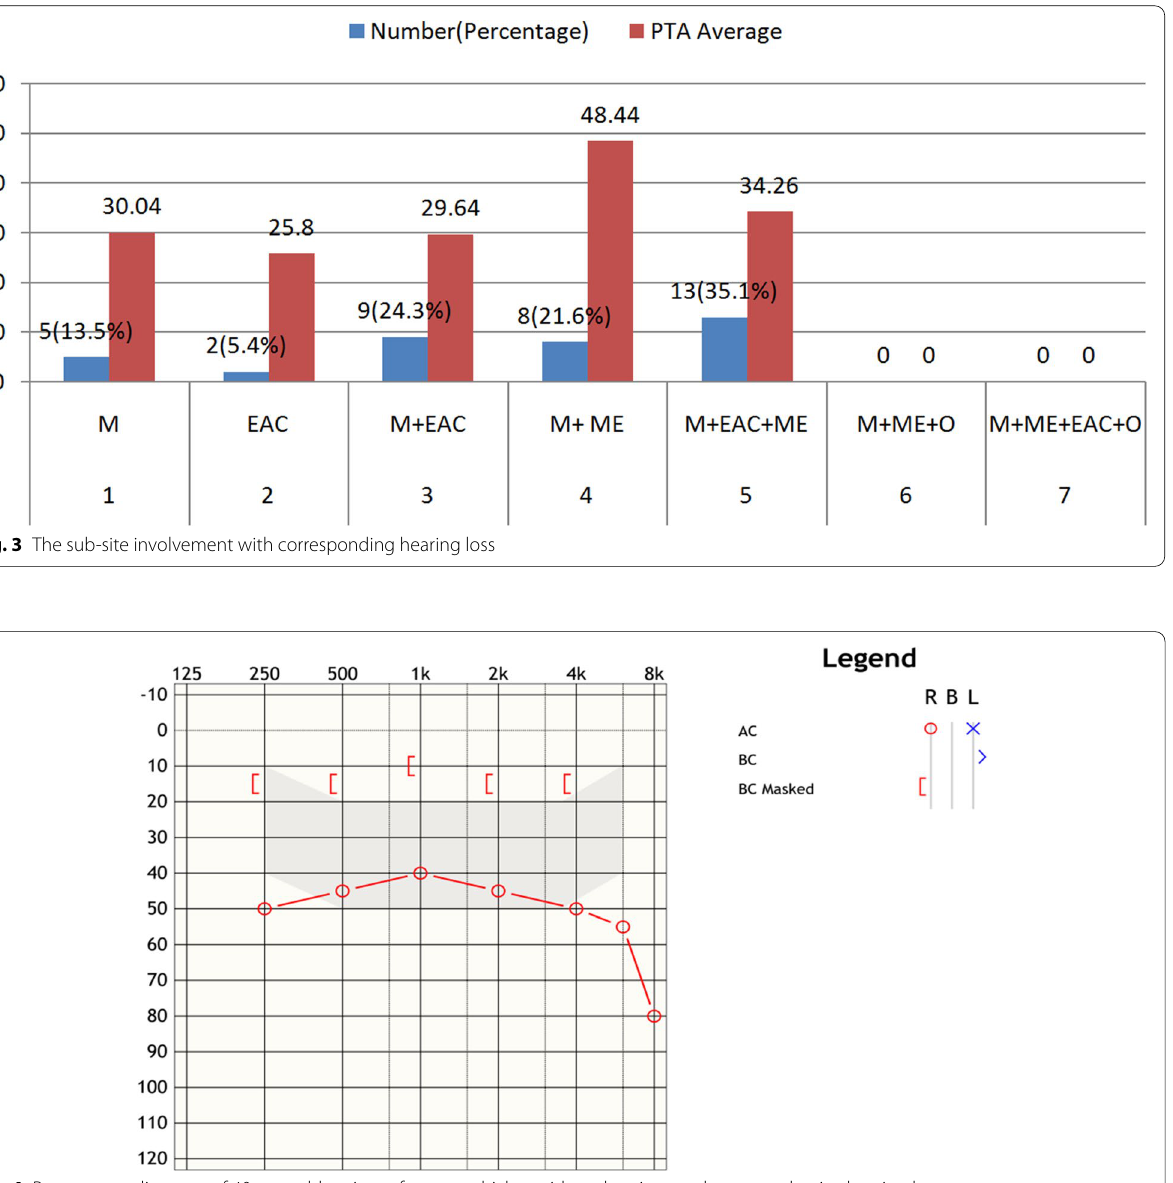
Fig. 4 Pure tone audiometry of 40-year-old patient of motor vehicle accident showing moderate conductive hearing